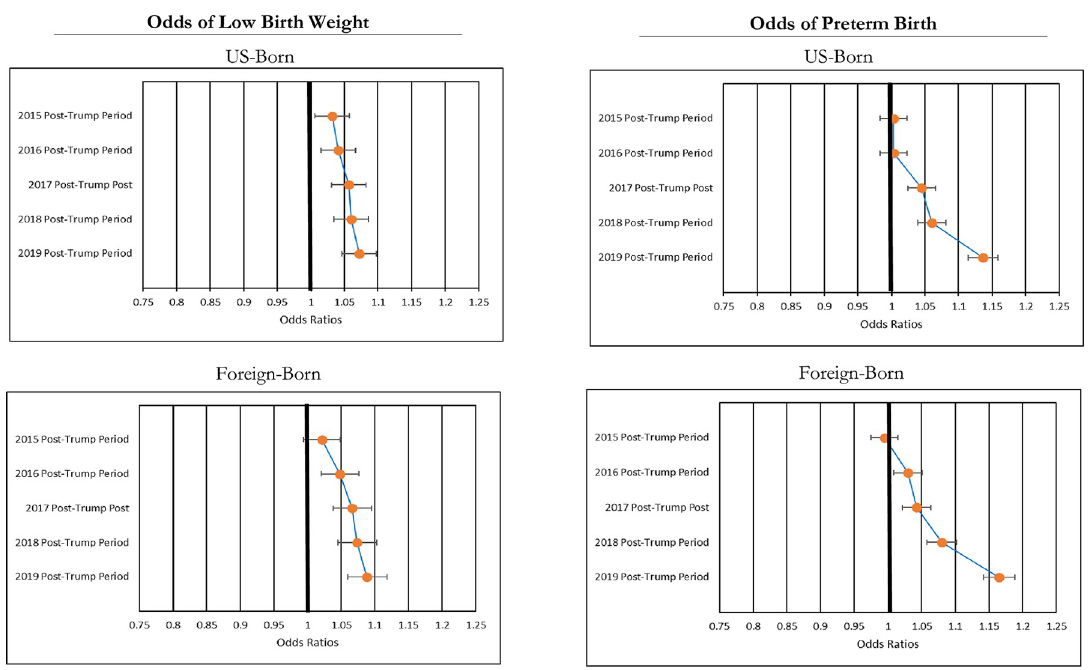
Fig 1. Adjusted odds of low birth weight and preterm birth, relative to pre-trump period by maternal nativity.